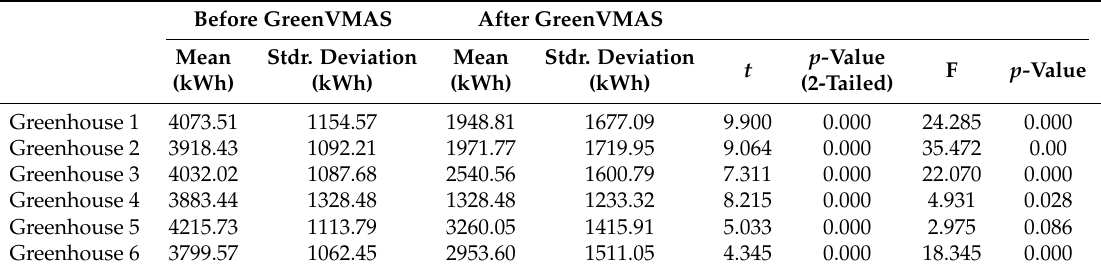
Table 10. Results of the Student’s t -test and Levene’s test conducted on the tomato crop in winter. These tests were performed to assess the difference of means (electrical consumption in kWh) and variances between the data obtained before and after using GreenVMAS. Before GreenVMAS After GreenVMAS p- Value Mean Stdr. Deviation Mean Stdr. Deviation t F p- (kWh) (kWh) (kWh) (kWh) (2-Tailed)